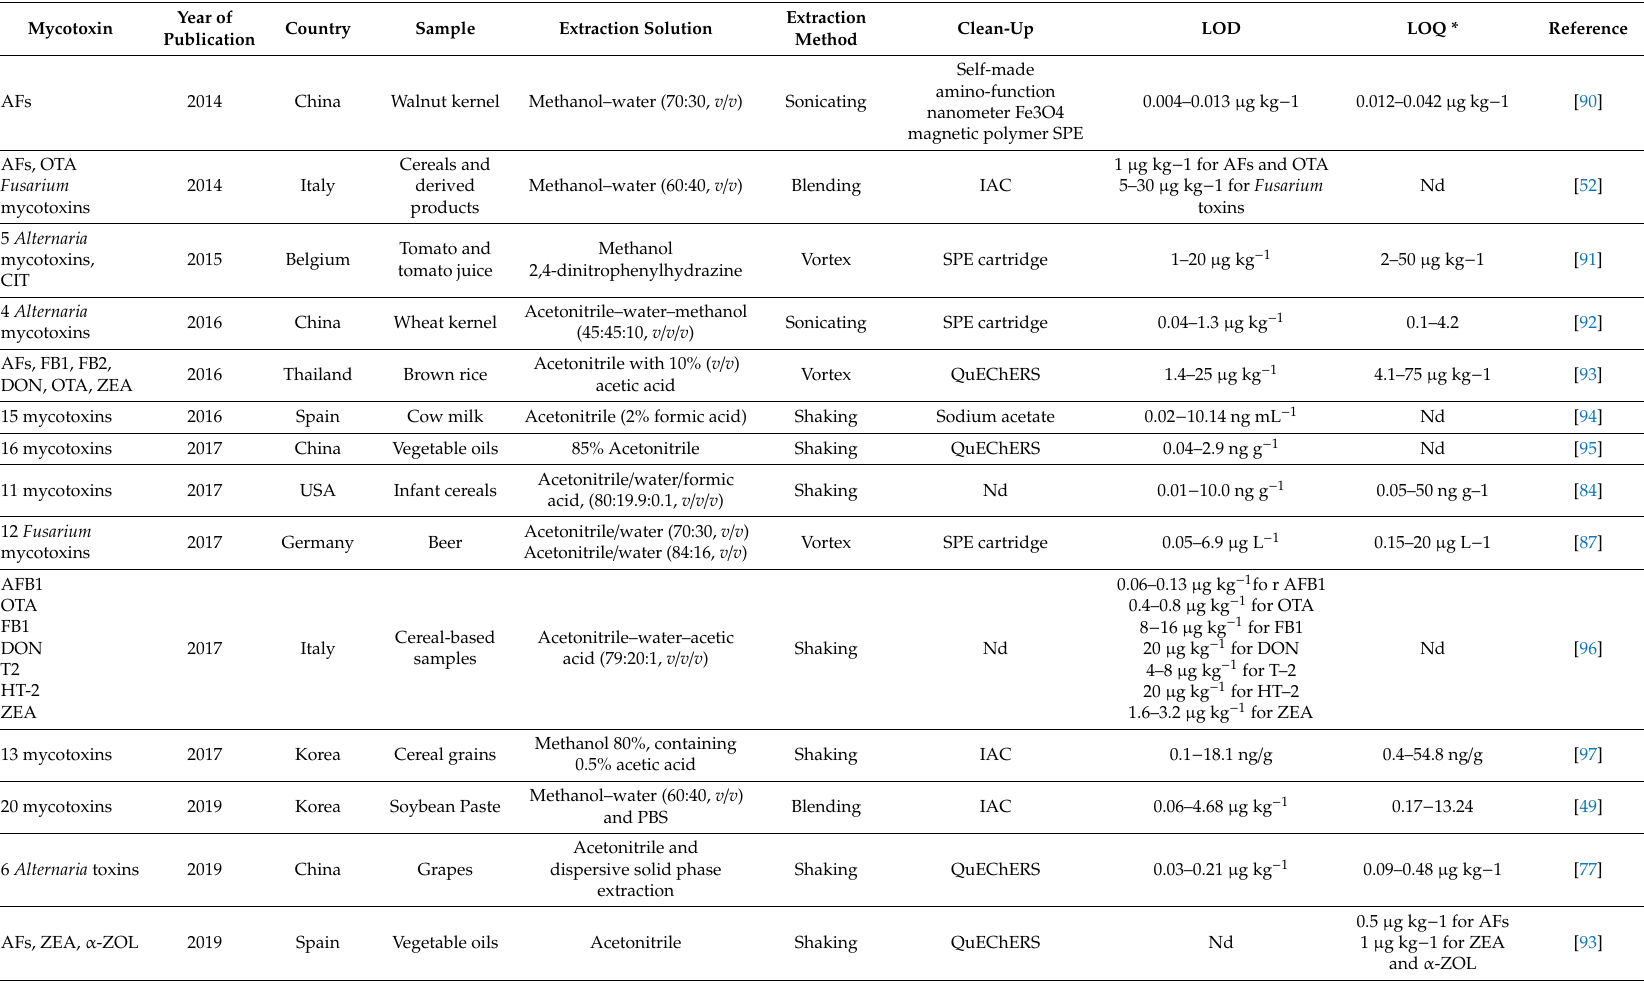
Table 3. Examples of liquid chromatography with tandem mass spectrometry (LC / MS-MS) methods in mycotoxins analysis in foods worldwide during 2014–2019.